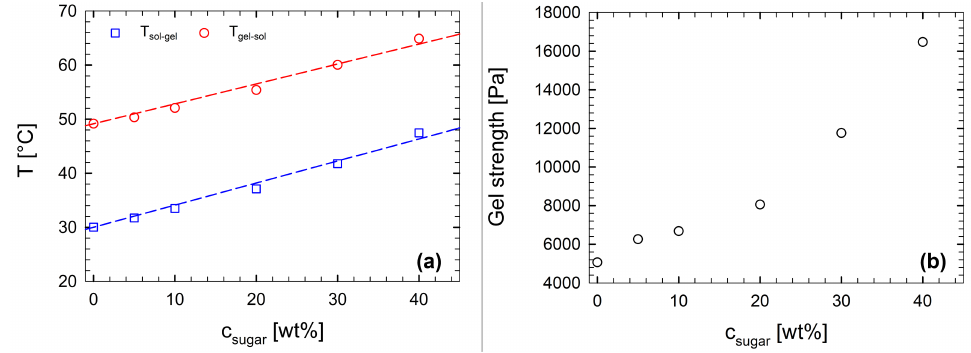
Figure 11. ( a ) T sol - gel and T sol - gel and ( b ) gel strength, as functions of the sugar percentage concen- tration for quaternary solutions, with a fixed amount of biopolymers (1.5 wt% κ -c and 1.3 wt% XG). Dashed lines are obtained via linear